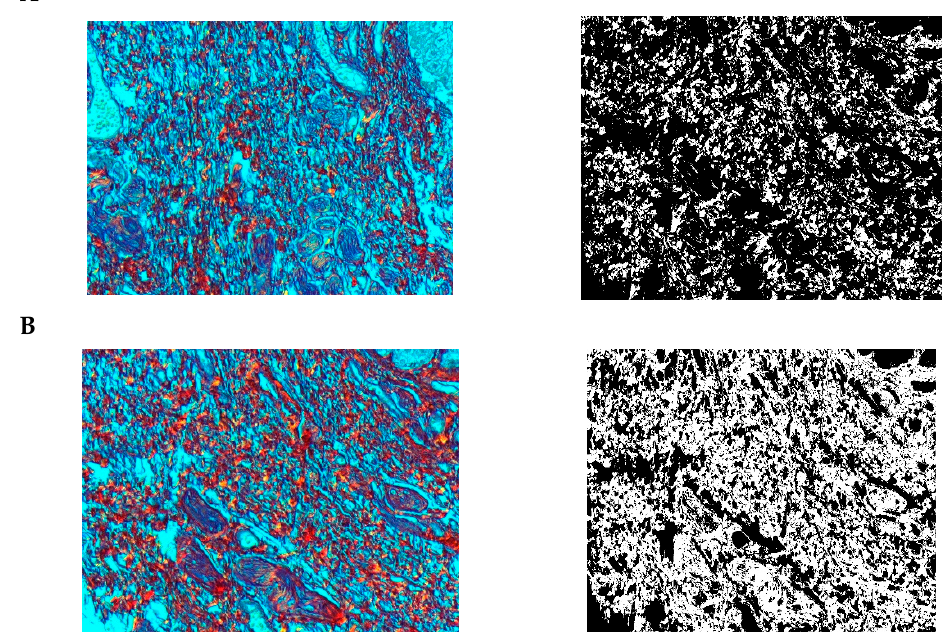
Figure 18. Segmentation before ( A ) and after ( B ) treatment (picrosirius red staining).